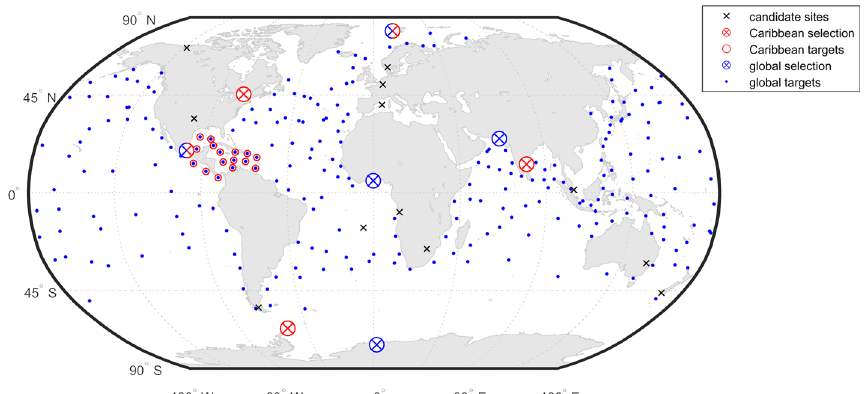
Fig. 3 Target locations are plotted for the global (blue dots) and Caribbean (red circles) scenarios. Alongside the locations of ground station selected for the global (blue, n pass = 4 in Fig. 1a) and Caribbean (red, n pass = 7 in Fig. 1c) scenarios, as well as other candidate